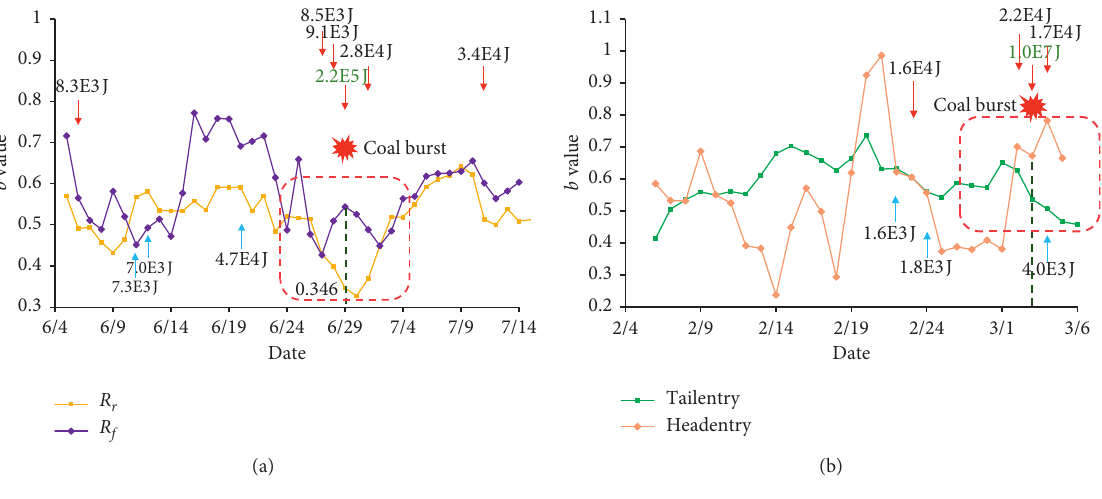
Figure 6: Variation curve of b value. (a) LW5521-20. (b) LW11-3102.